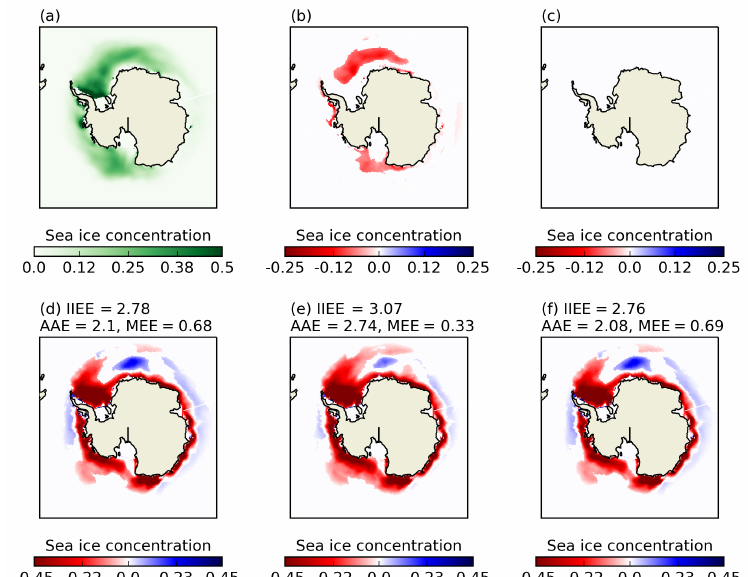
Figure 9. Sea ice concentration averaged over DJF 1992–2014 for (a) the standard model simulation with a floe diameter of 300m; (b) a model simulation with a floe diameter of 1m (small floes) minus (a) ; and (c) a model simulation with a floe diameter of 10000m (large floes) minus (a) . Panels (d–f) show simulation minus observed Bootstrap sea ice concentration, where the latter has been interpolated on to the model grid for (d) the standard model simulation, (e) the small floes simulation, and (d) the large floes simulation. In (b–f) , differences are shown only if they are statistically different according to a Student’s t test over 1992–2014 ( p < 5%). Labels on (d–f) show the integrated ice extent error, absolute extent error and misplacement extent error in millionkm 2